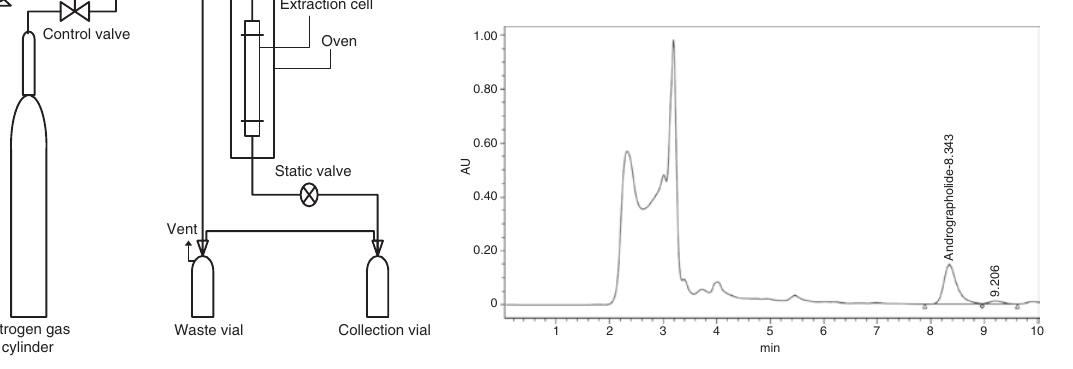
Figure 3: High-performance liquid chromatography (HPLC) chroma- togram of Andrographis paniculata (AP) water